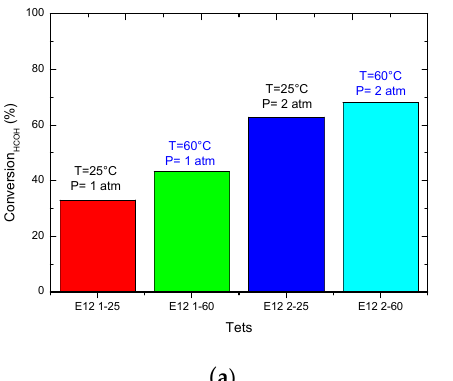
Figure 4. ( a ) Results of conversion of CWO of HCOH at pressure 1 and 2 atm and temperature 25 and 60 °C, ( b ) FTIR of the precipitate of the CWO